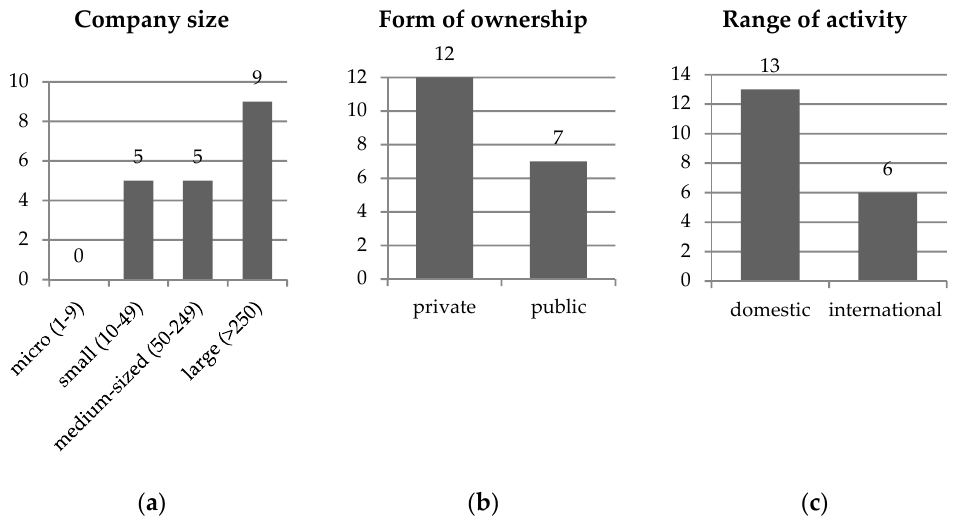
Figure 2. Basic data on the railway enterprises investigated.